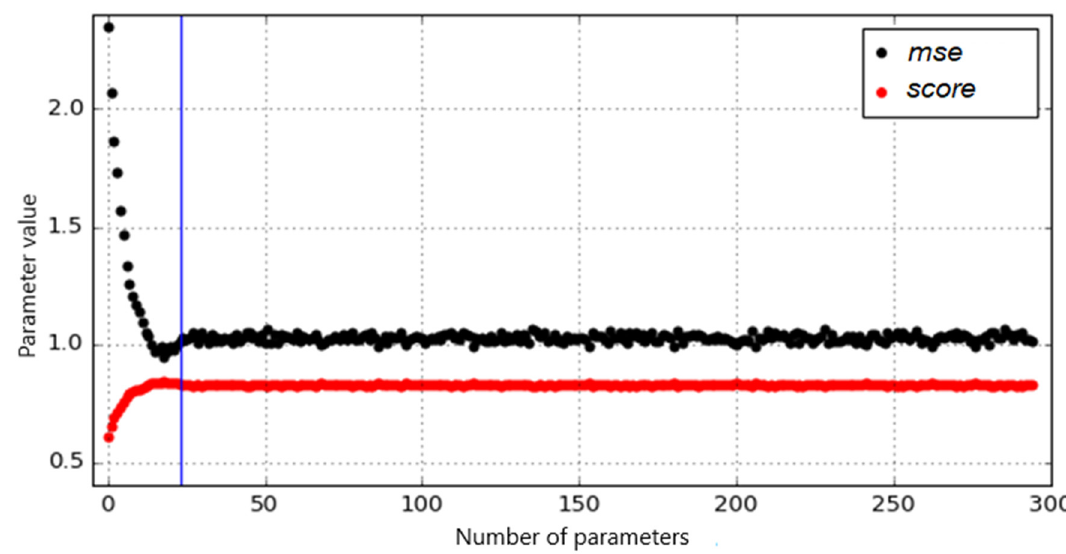
Figure 3. Specifics of the max depth parameter for the decision-tree regression method.